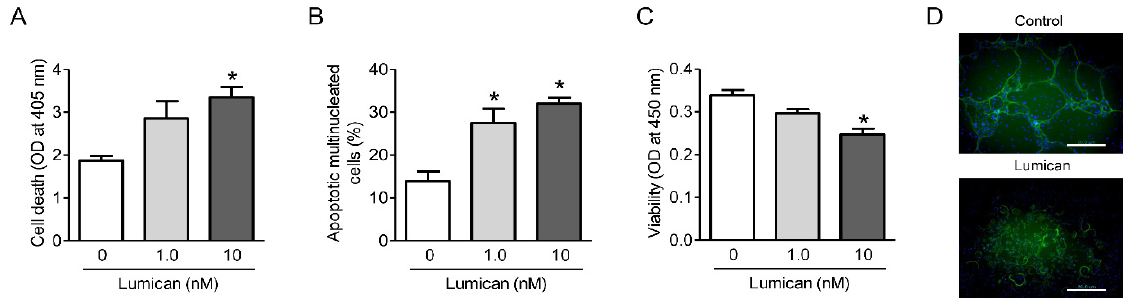
Figure 4. Lumican increases osteoclast apoptosis and decreases osteoclast viability and actin ring formation. ( A , B ) Primary mouse BMMs were cultured with 30 ng/mL RANKL and 30 ng/mL M-CSF for 4 days, and then RANKL was withdrawn and the cells were cultured with 1 nM or 10 nM lumican for an additional 1 day. Apoptosis was determined by Cell Death ELISA and TUNEL assays, respectively ( n = 5). ( C ) Primary mouse BMMs were cultured with 30 ng/mL RANKL and 30 ng/mL M-CSF for 4 days, and then assayed for viability using a CCK-8 assay after treatment with 1 nM or 10 nM lumican for an additional 1 day ( n = 3). ( D ) F-actin staining was performed to assess actin ring formation after treatment of mouse BMMs for 4 days with 30 ng/mL RANKL and 30 ng/mL M-CSF in the presence of 10 nM lumican ( n = 3). Scale bars: 20 μ m ( D ). Data are means ± SEM. * p < 0.05 vs. untreated control.